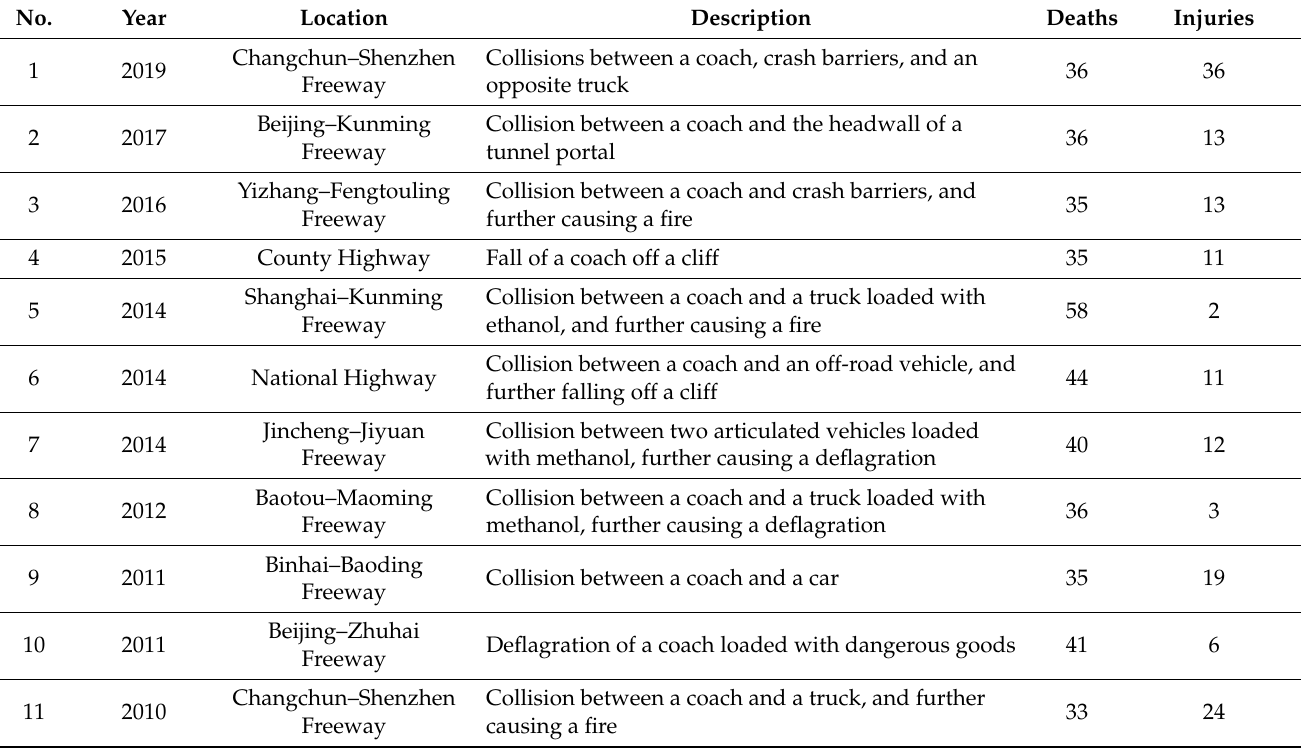
Table 1. The particularly major accident cases related to commercial vehicles within